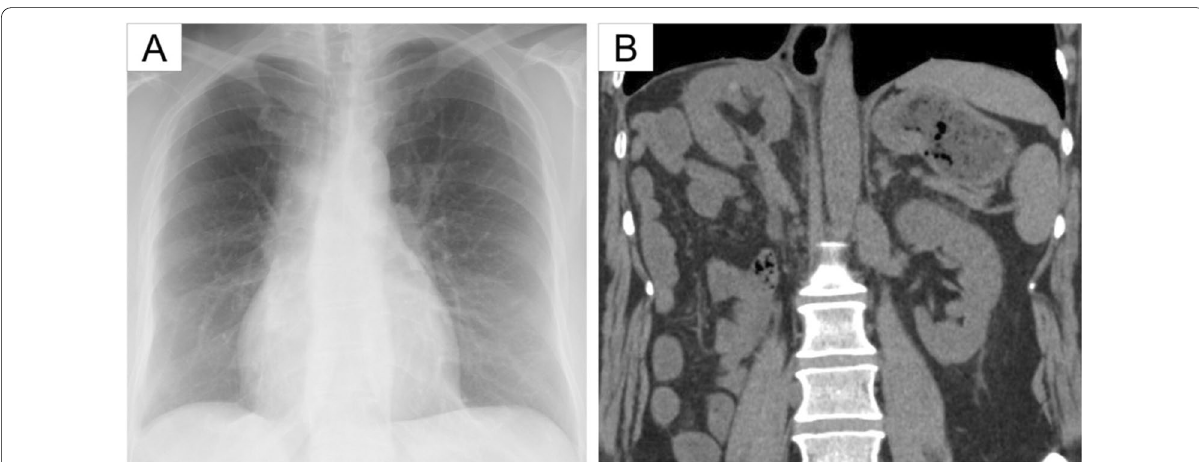
Fig. 6 Postoperative chest radiograph ( a ) and coronal abdominal computed tomographic (CT) scan ( b ). a Massive area of opacity had completely disappeared. b No recurrence of the diaphragmatic hernia was confirmed 20 months after the